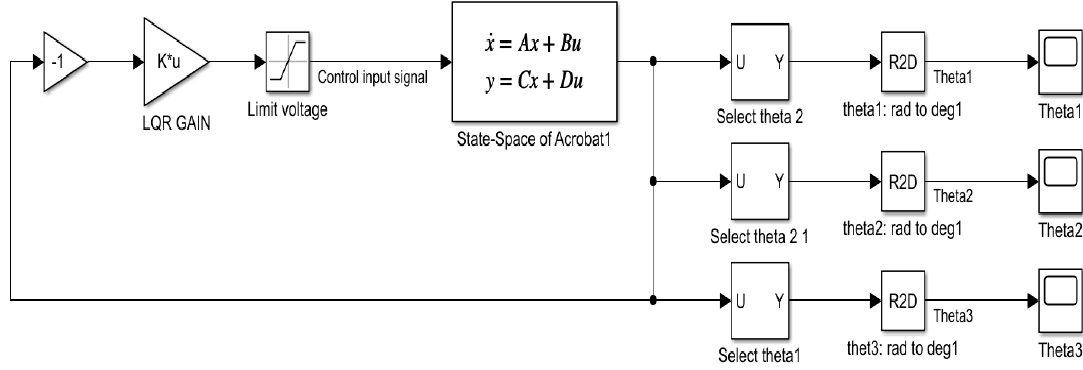
Figure 2. LQR simulation.